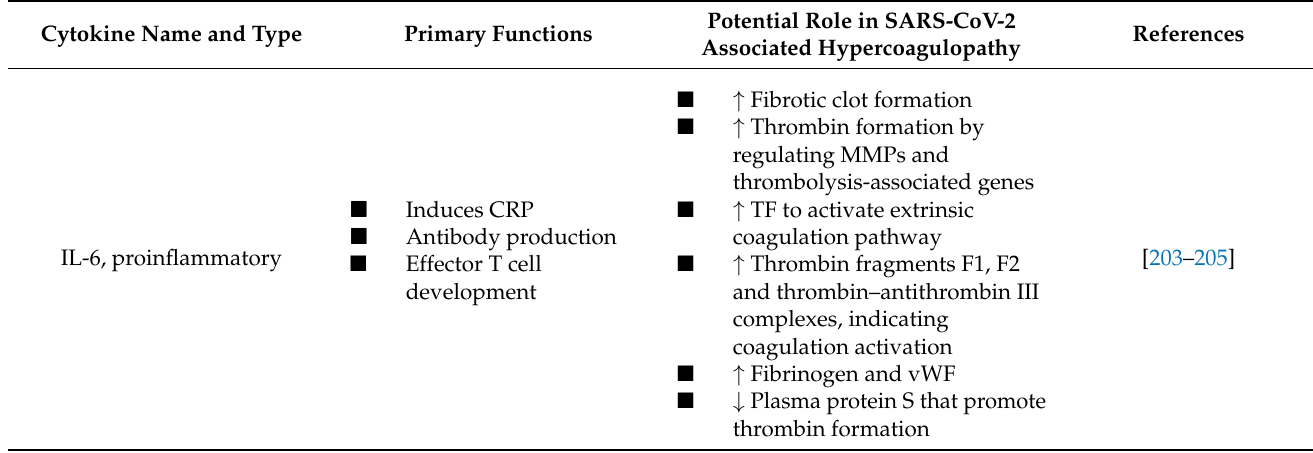
Table 1. Cytokine directory in relation to SARS-CoV-2 associated